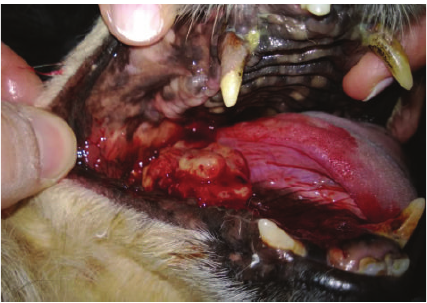
Figure 1: Picture taken on day 1, before the ECT treatment. On the right side of the mouth a 3.8 × 2.2 × 1.2 cm bloody mass can be seen corresponding to an eosinophilic